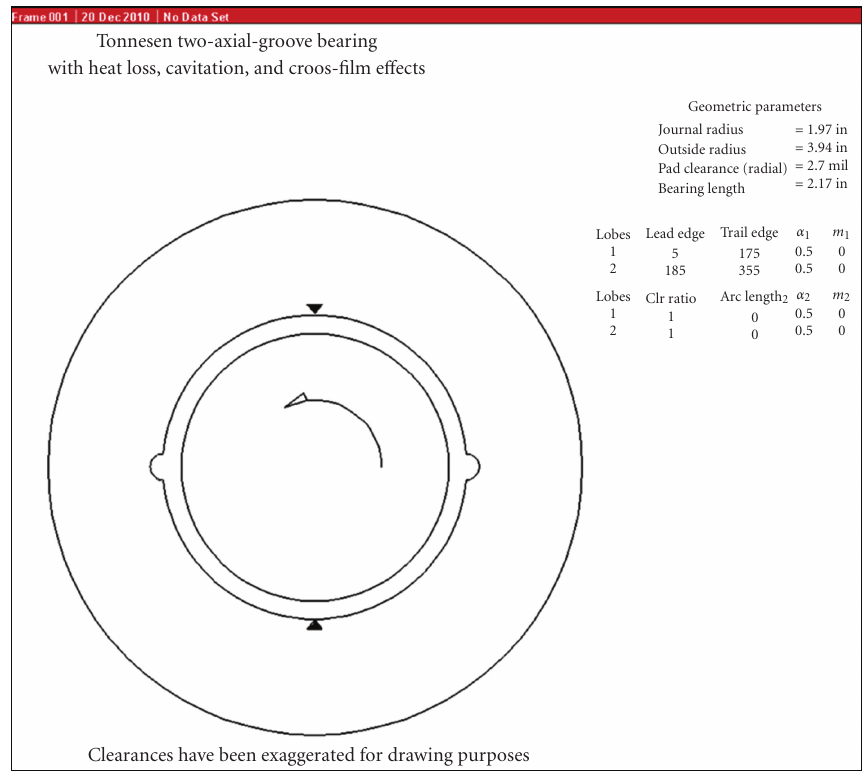
Figure 3: A two axial groove fluid film